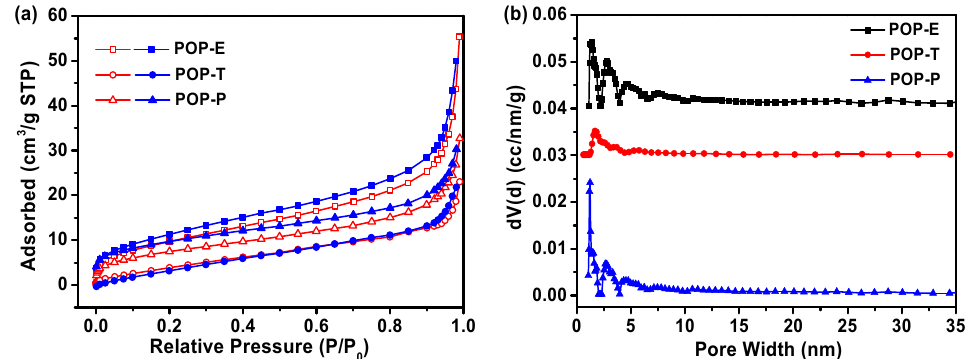
Figure 2. ( a ) Nitrogen adsorption/desorption isotherms of POP-E, POP-T and POP-P. ( b ) Pore size distributions of POP-E, POP-T and POP-P.